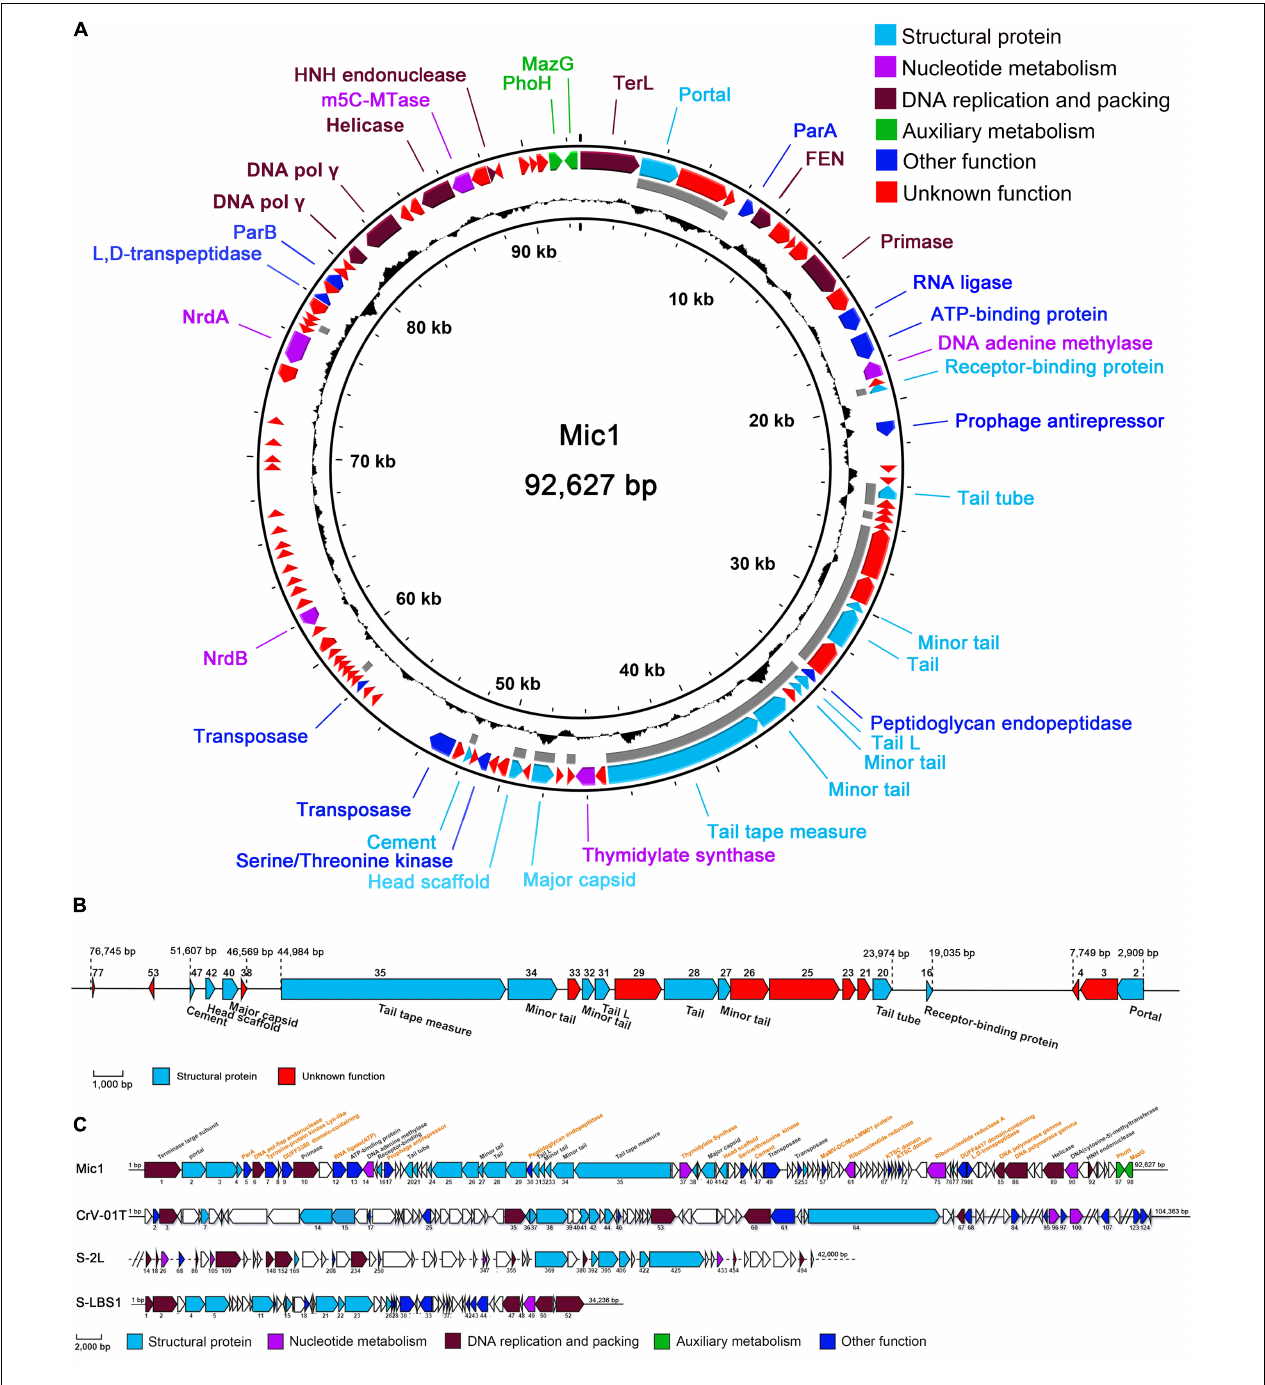
FIGURE 2 | Genomic analyses of Mic1. (A) The circular genomic map of Mic1. Circles from the outmost to the innermost correspond to: (I) Predicted ORFs (BLASTp, nr database) with functions are labeled in different colors around the circular map; (II) Gray lines show the structural proteins identified by mass spectrometry; (III) GC content plotted relative to the genomic mean of 35% G + C. (B) The structural proteins of Mic1 identified by LC-MS. (C) The genomic comparison of four freshwater cyanosiphophages. The unique ORFs of Mic1 are labeled in yellow.